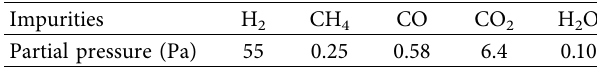
Table 2: Impurity contents in helium at atmospheric pressure